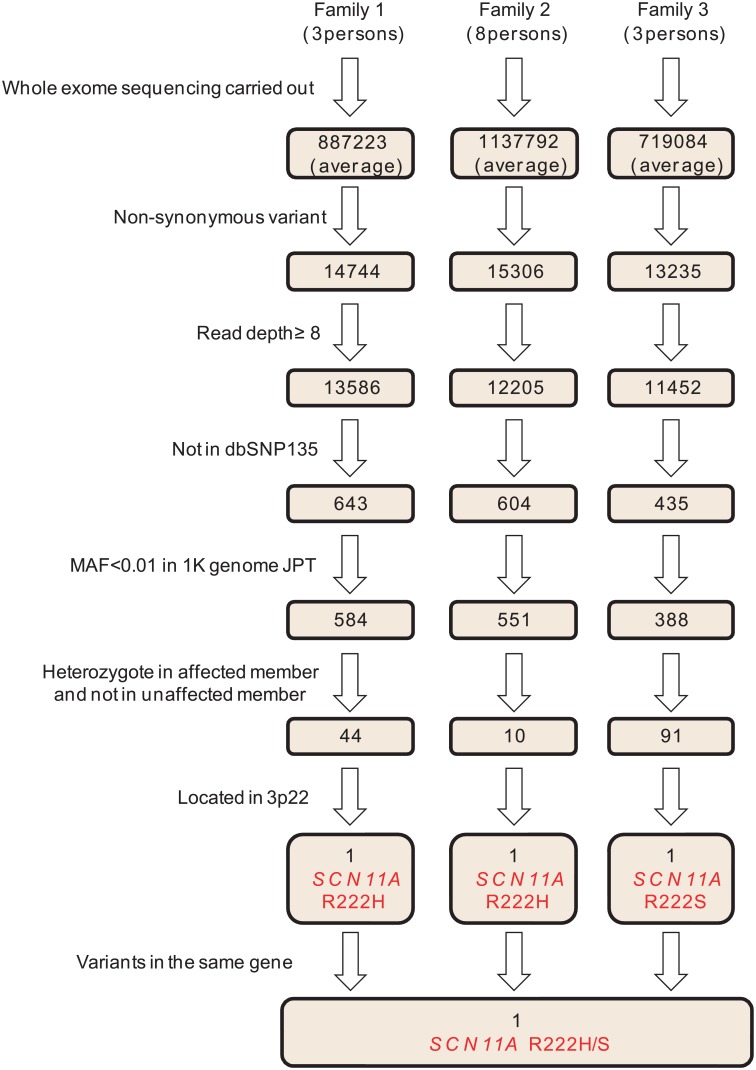
Exome analysis filtering process in the three Japanese familial episodic pain syndrome families.Exome analysis was performed for three affected members in Family 1, four affected and four unaffected members in Family 2, and two affected and one unaffected member in Family 3. Exome data was processed through seven filtering steps: (1) non-synonymous, (2) read depth ≥ 8, (3) not registered in dbSNP135, (4) MAF < 0.01 in Japanese patients from 1000 Genomes database, (5) heterozygote in affected members and not present in unaffected members, (6) located on 3p22 linkage region, and (7) variants in the same gene among all three families. Numbers in boxes represent the numbers of variants after each filtering step.